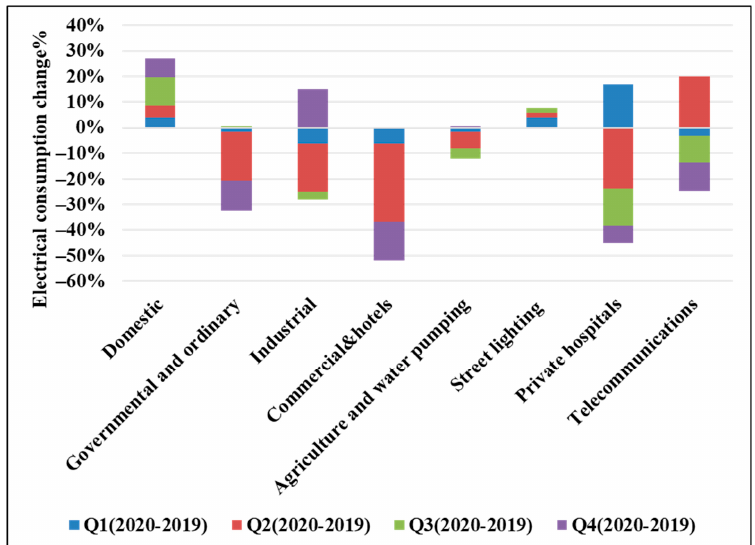
Figure 15. Change in electricity consumption in IDECO’s region by quarter between 2019 and 2020.